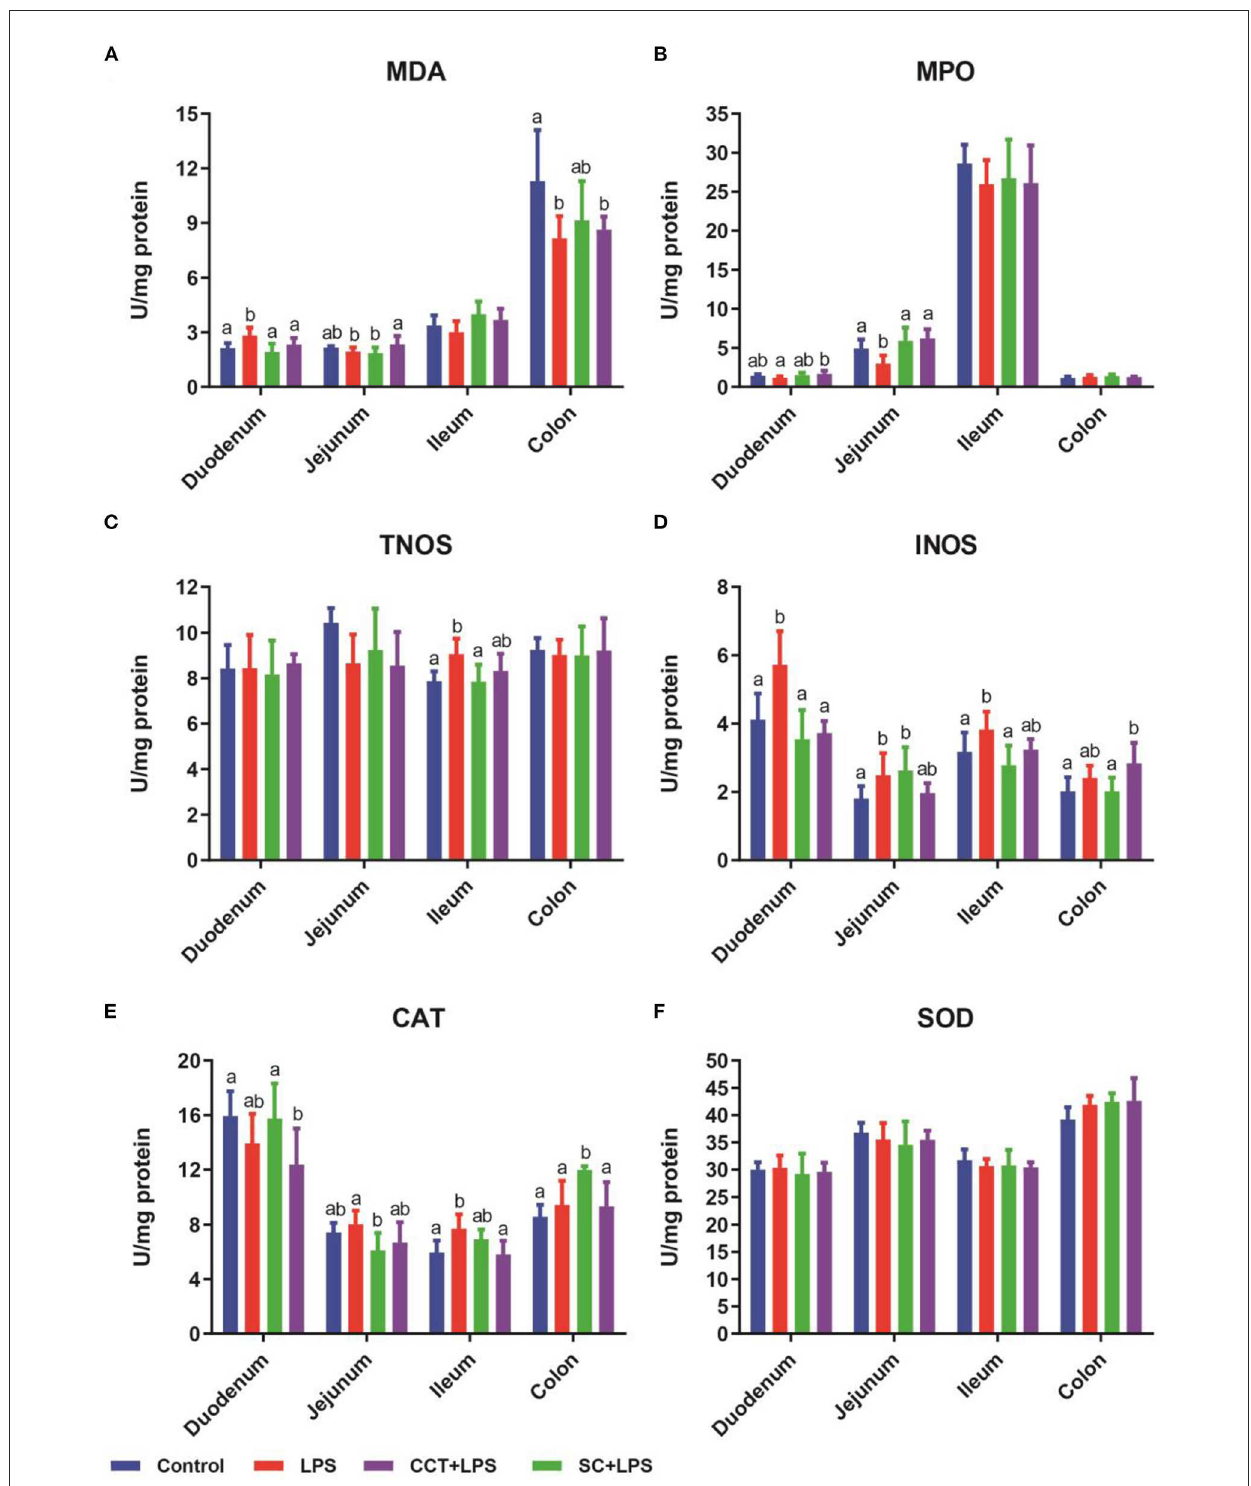
FIGURE2 Effects of CCT and CS supplementation on intestinal redox status in LPS-challenged piglets. Data are means ± SD, n = 6, CS, colistin sulfate; CCT, a complex of cinnamaldehyde, carvacrol and thymol; malondialdehyde (MDA) in duodenum ( p = 0.005), jejunum ( p = 0.042), ileum ( p = 0.077) and colon ( p = 0.046) (A) ; myeloperoxidase (MPO) in duodenum ( p = 0.055), jejunum ( p = 0.001), ileum ( p = 0.649) and colon ( p = 0.192) (B) ; total nitric oxide synthase (tNOS) in duodenum ( p = 0.914), jejunum ( p = 0.099), ileum ( p = 0.016) and colon ( p = 0.965) (C) ; inducible nitric oxide synthase (iNOS) in duodenum ( p < 0.001), jejunum ( p = 0.037), ileum ( p = 0.016) and colon ( p = 0.015) (D) ; catalase (CAT) in duodenum ( p < 0.048), jejunum ( p = 0.049), ileum ( p = 0.006) and colon ( p = 0.001) (E) ; superoxide dismutase (SOD) in duodenum ( p < 0.860), jejunum ( p = 0.635), ileum ( p = 0.640) and colon ( p = 0.120) (F) . Differences among treatment means were determined using Duncan’s post-hoc tests. a,b Means within rows with different superscripts differ ( P <